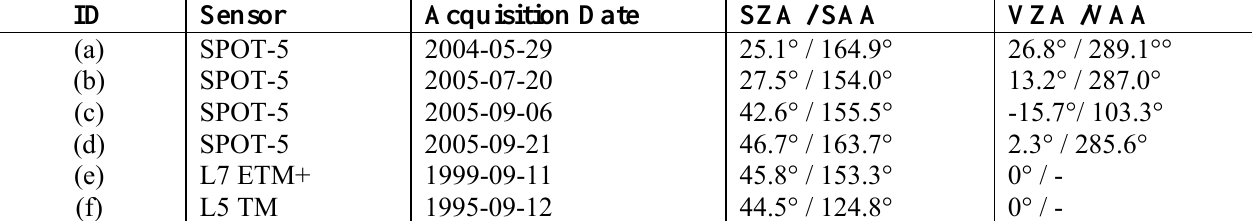
Table 1. List of scenes (SZA = solar zenith angle, SAA = solar azimuth angle, VZA = view zenith angle, VAA = view azimuth